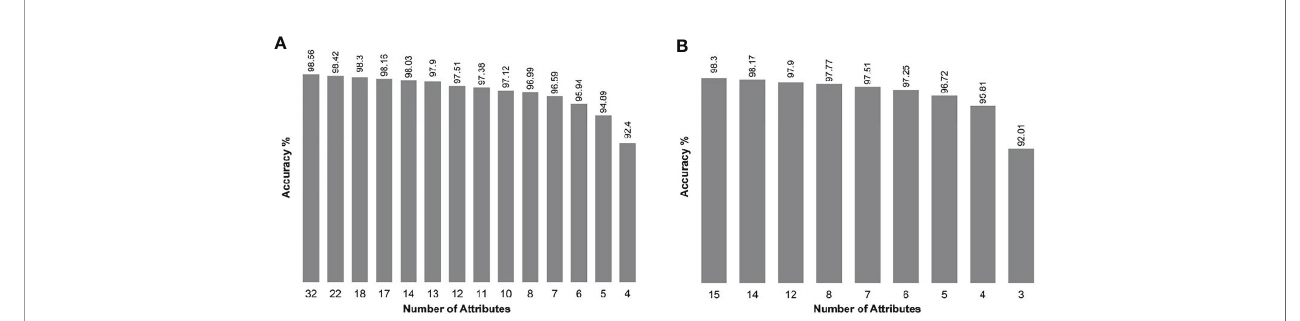
FIGURE 1 | Accuracy of the smallest best-performing gene sets output by the SARC classi fi er, applied on the GSE85217 dataset (n = 763 samples), (A) when introducing all 21,641 attributes as input, and (B) when introducing the Nanostring 22-gene set as